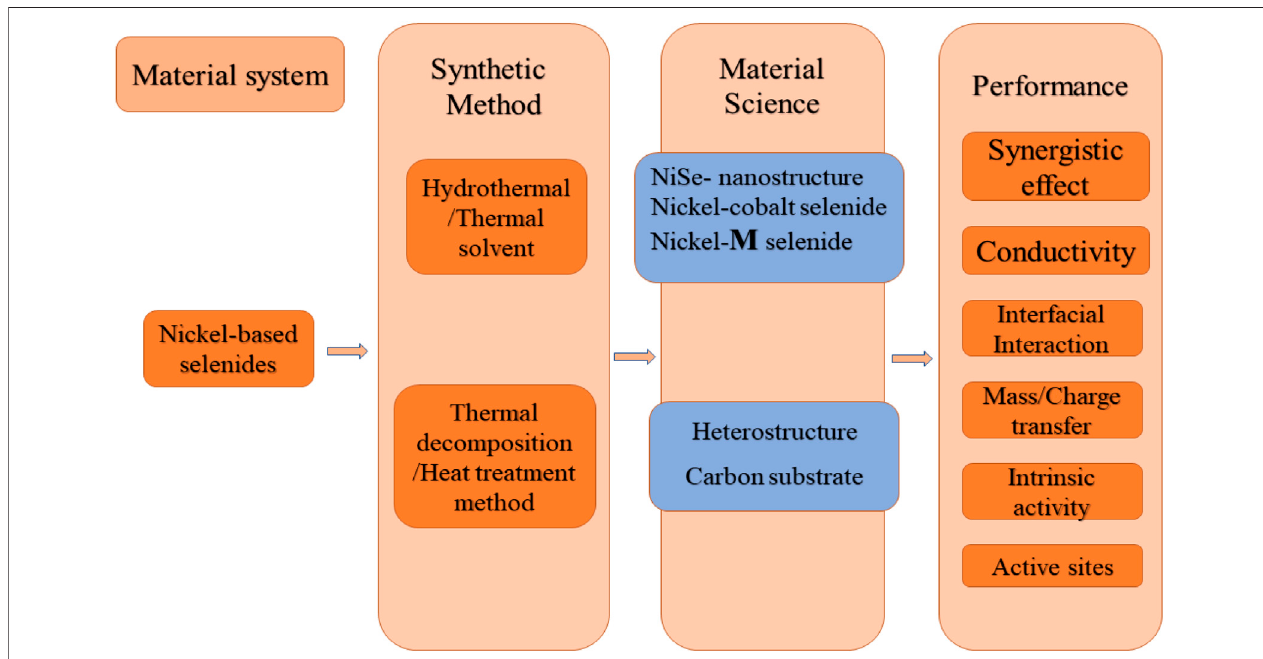
FIGURE 2 | An illustration of the key performance metrics, the affecting factors in evaluation of SCs, where nickel-based selenides are shown to play major roles in development of high performance supercapacitors.